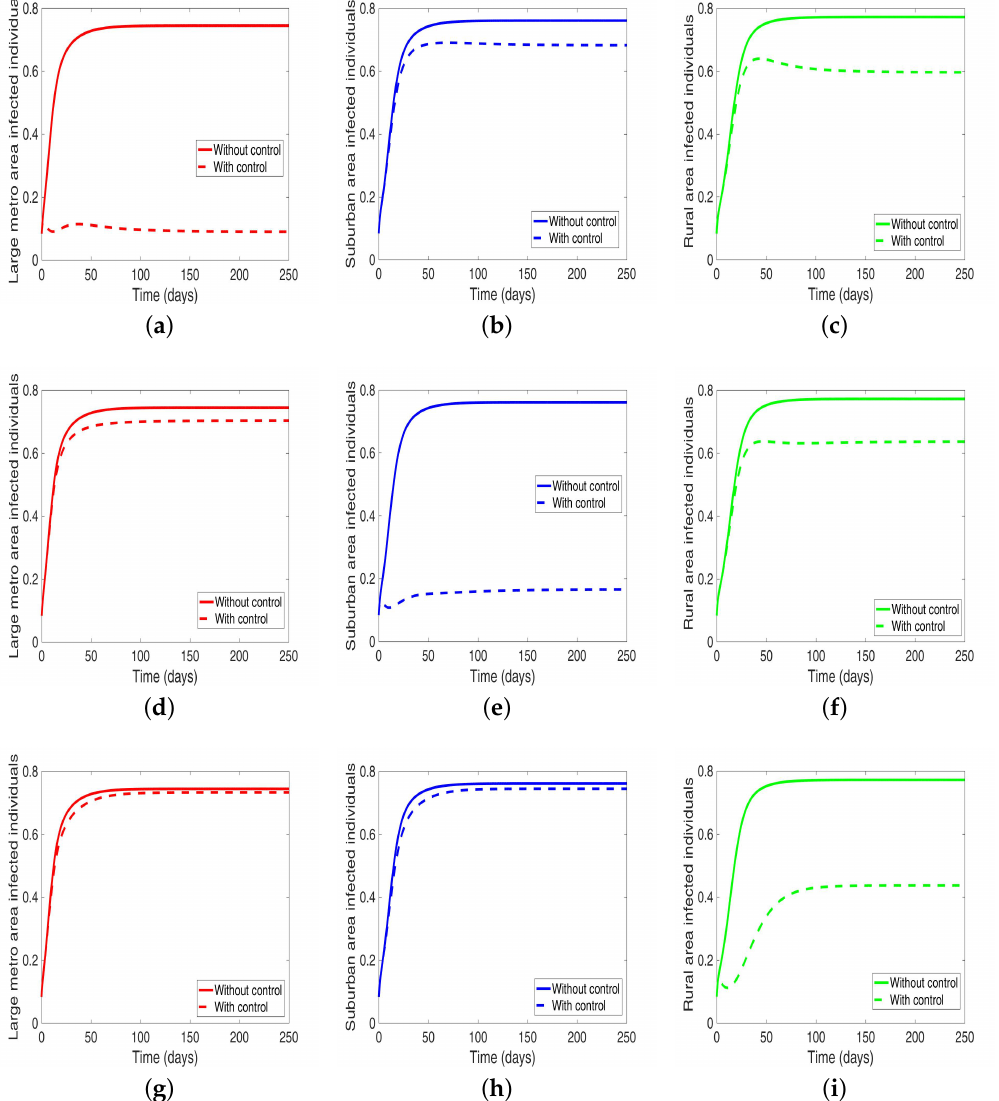
Figure 12. MRSA model simulation with movement, disease, and behavioral control in large metro area only ( a – c ). Movement, disease, and behavioral control in suburban area only ( d – f ). Movement, disease, and behavioral control in rural area only ( g – i ). ( a ) Infected individuals in large metro area. ( b ) Infected individuals in suburban area. ( c ) Infected individuals in rural area. ( d ) Infected individuals in large metro area. ( e ) Infected individuals in suburban area. ( f ) Infected individuals in rural area. ( g ) Infected individuals in large metro area. ( h ) Infected individuals in suburban area. ( i ) Infected individuals in rural area. Parameter values used are given in Tables